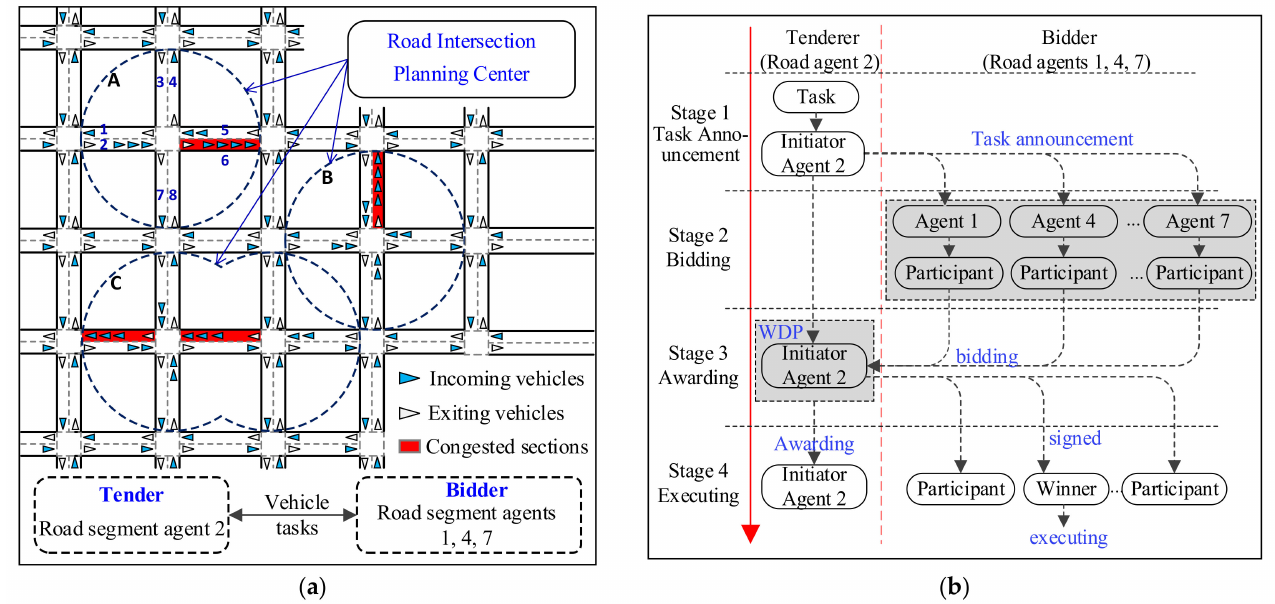
Figure 3. Schematic of the bidding-based vehicle-road coordination planning. ( a ) road intersection planning center model; ( b ) four stages of vehicle-road